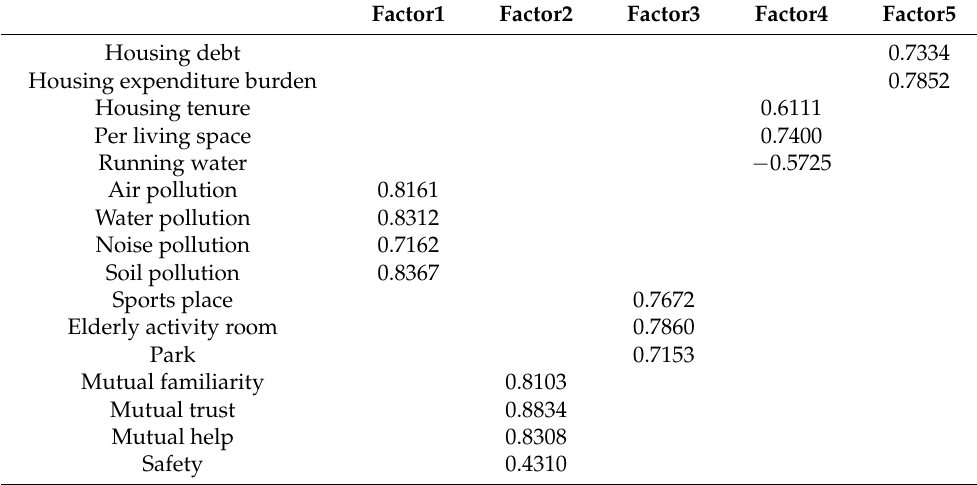
Table 4. Matrix of